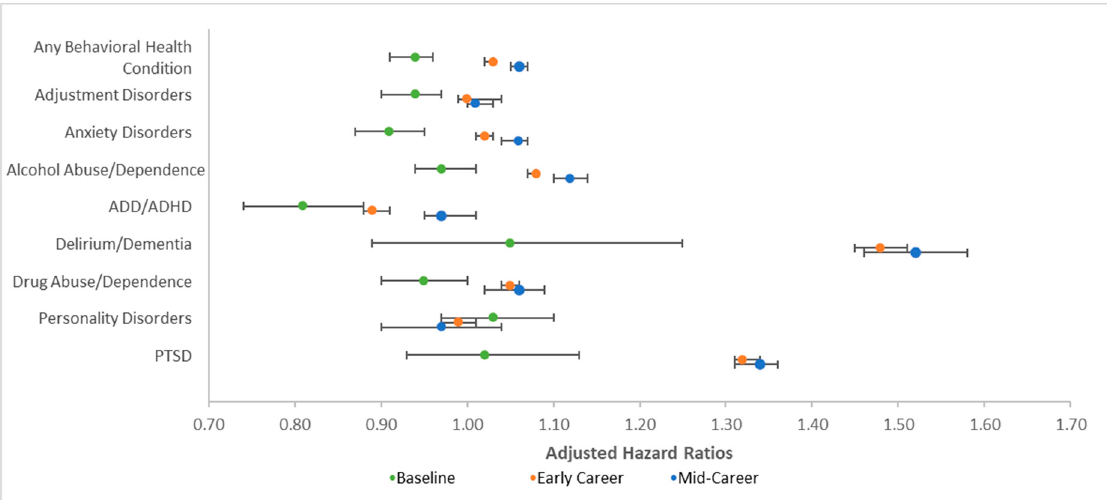
Figure 4. Graph of adjusted hazard ratios depicting decomposition of significant interaction between occupational risk of low-level blast (LLB) and time in service for behavioral health conditions. Adjusted hazard ratios represent the odds of being diagnosed with the conditions denoted as a function of occupational risk of LLB. Error bars represent 95% confidence intervals; all error bars are included, but some are not visually apparent as they are so close to the point estimate (e.g., upper bound for any behavioral health condition). ADD/ADHD, attention-deficit disorder/attention-deficit/hyperactivity disorder; PTSD, posttraumatic stress disorder.